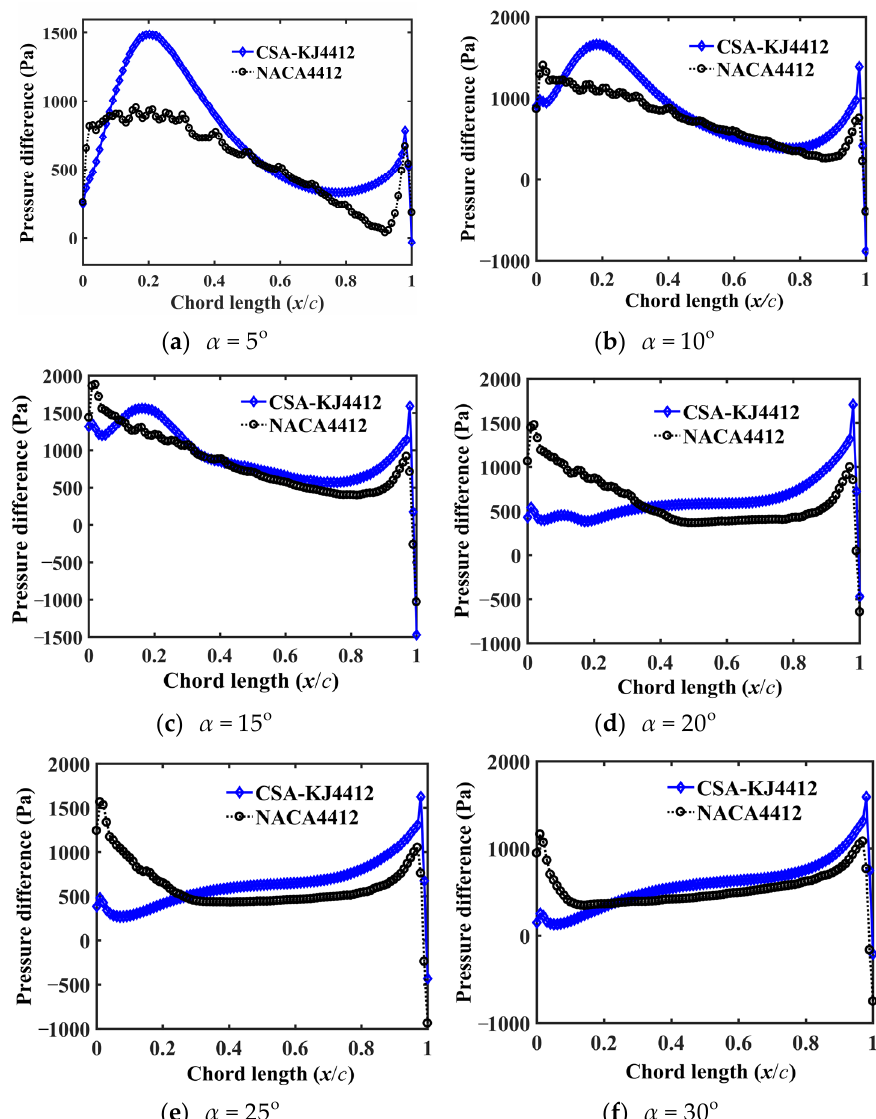
Figure 8. Pressure difference of two airfoils at different angles of attack.